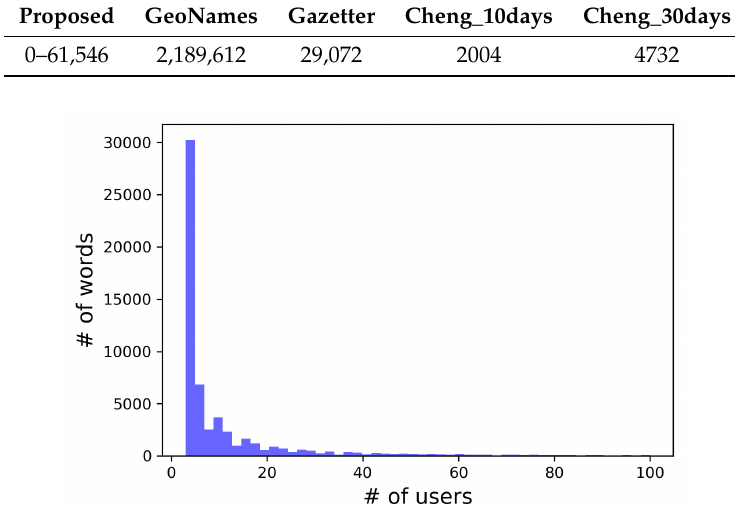
Figure 13. Number of users for the extracted local words. Those used by 5, 10, and 20 users accounted for 50%, 70%, and 80% of the extracted local